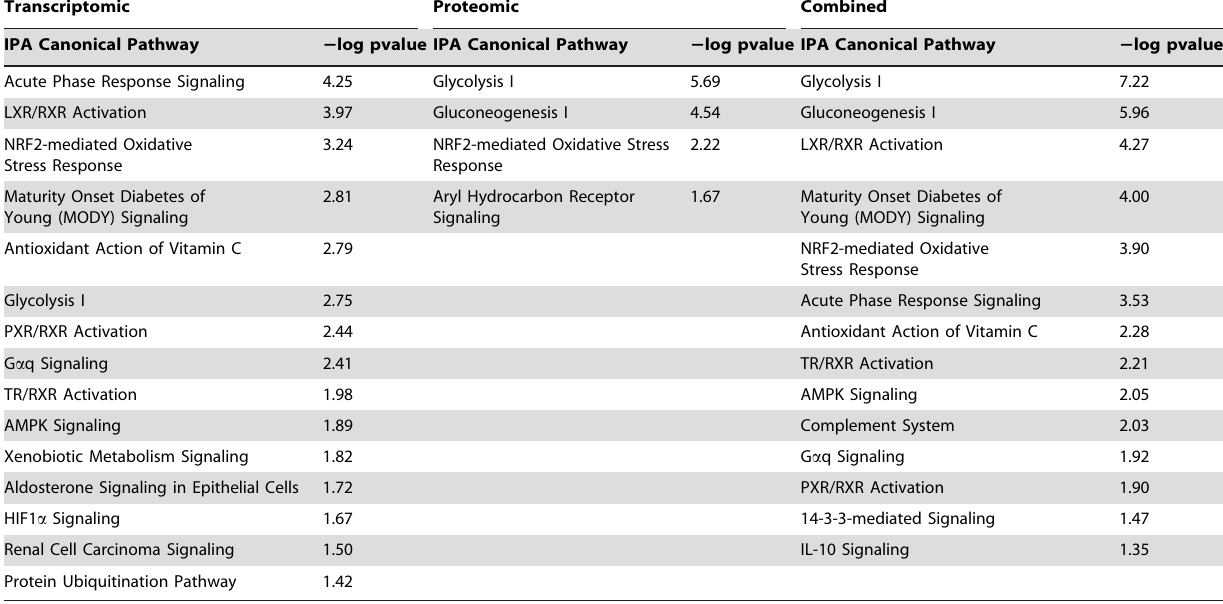
Transcriptomic Proteomic